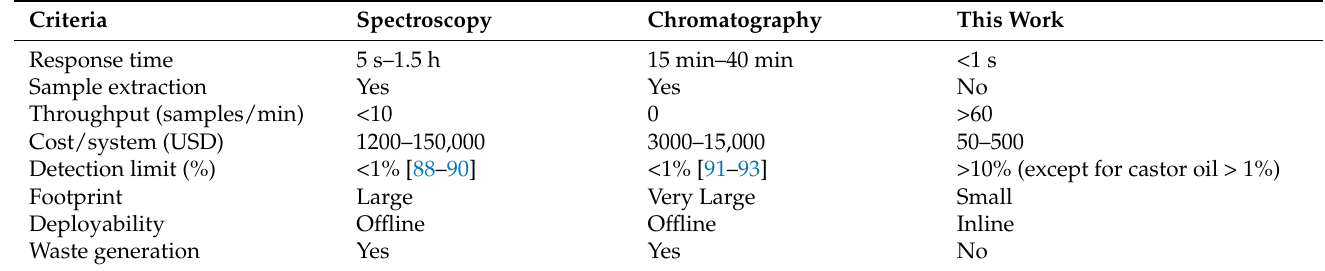
Table 4. A benchmark table of the proposed capacitive detection against the standard industrial edible oil authenticity testing